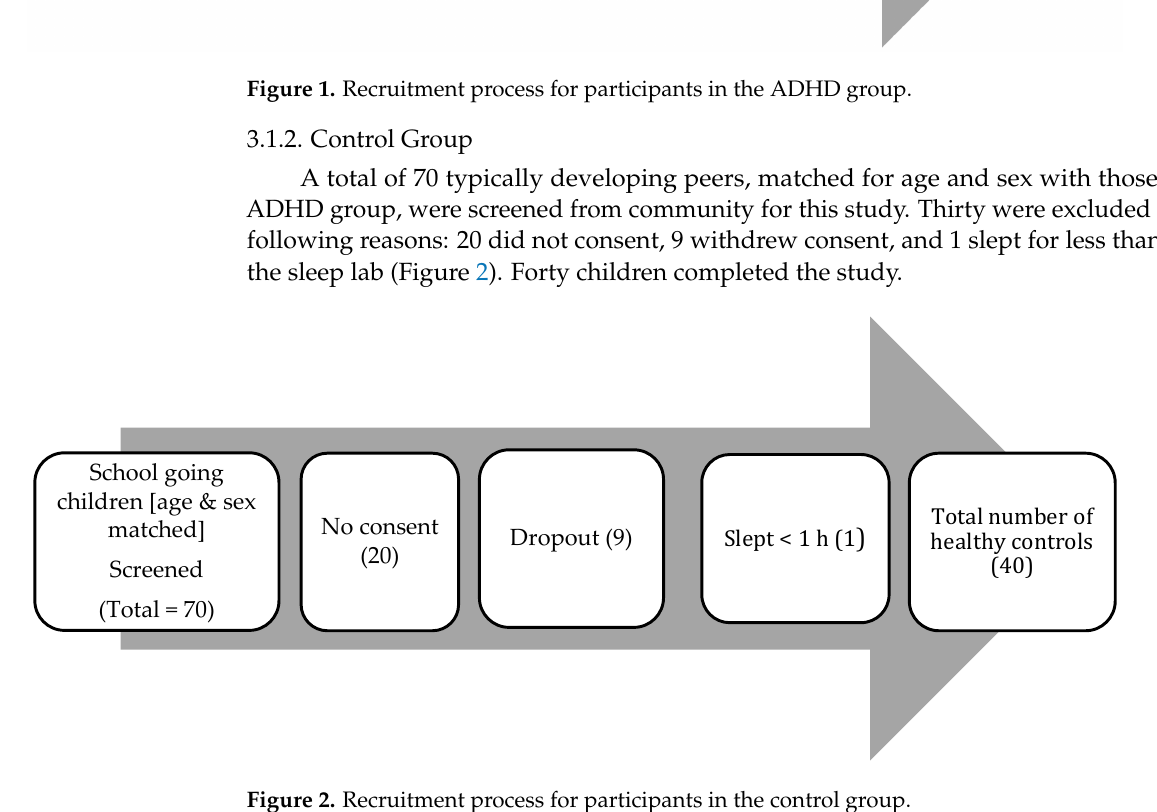
Table 1. Comparison of physical characteristics, IQ, parental demographics, and family monthly income between ADHD and control group.